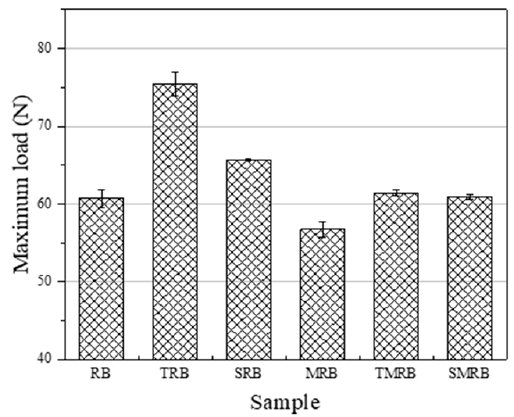
Figure 6. Maximum load of rubberized bitumen.